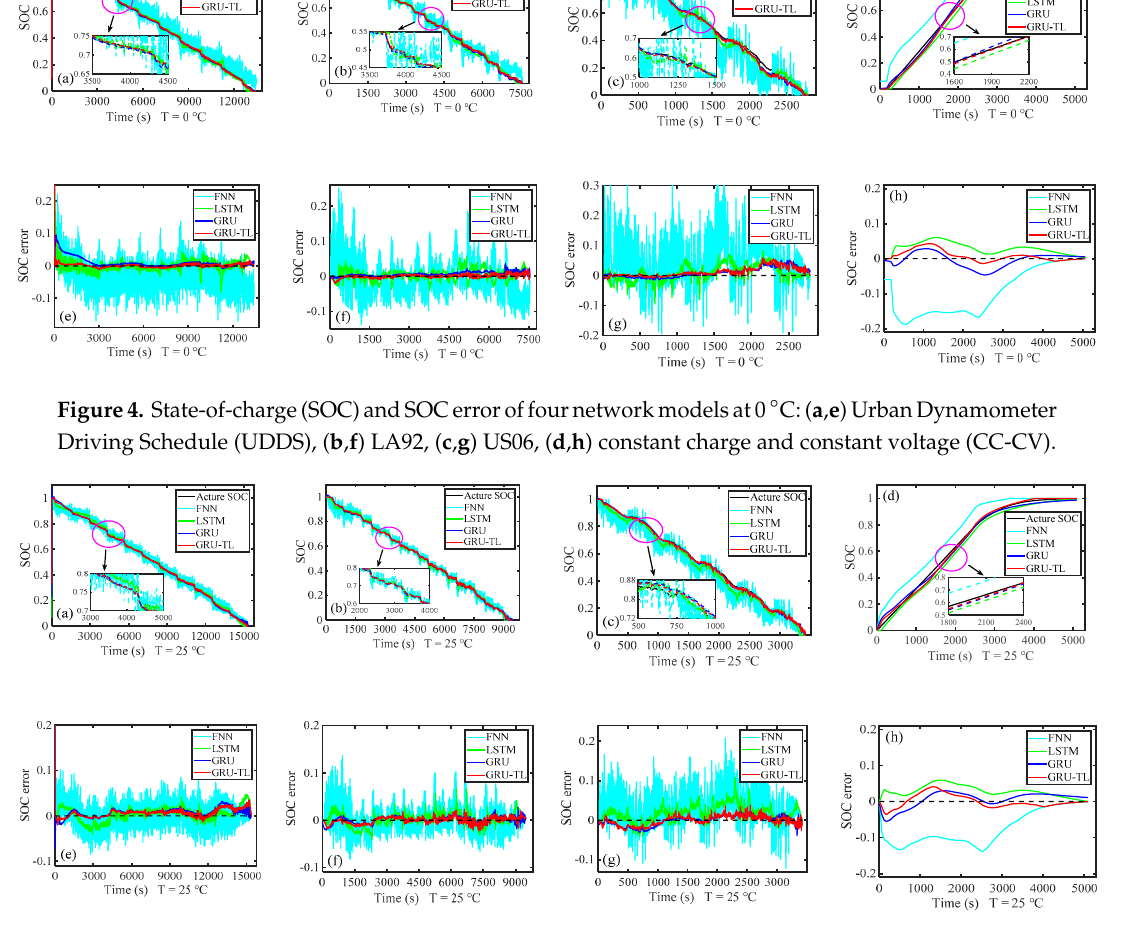
Figure 5. SOC and SOC error of four network models at 25 ◦ C: ( a , e ) UDDS, ( b , f ) LA92, ( c , g ) US06, ( d , h )